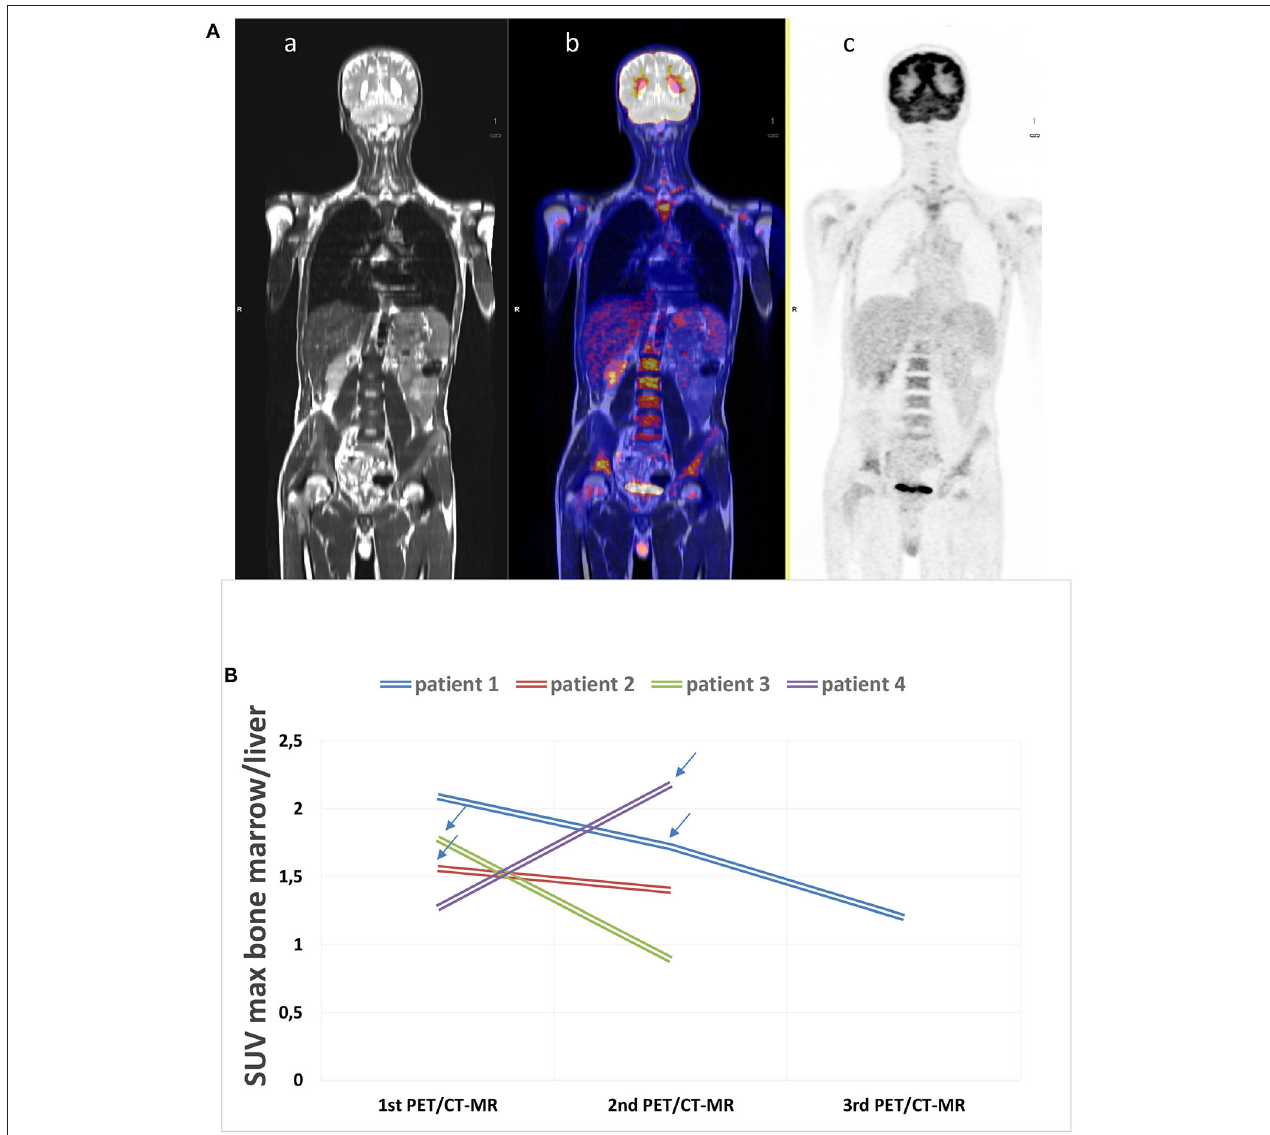
FIGURE 1 | (A) Example of an 18 F-fluorodeoxyglucose ( 18 F-FDG) positron emission tomography with magnetic resonance (PET/CT-MR) scan at disease onset. (a) MR whole-body image, T1 turbo spin echo, coronal (WB_t1_tse_cor), (b) fused image, and c) PET acquisition image with attenuation correction (PET_AC). This scan shows a diffusely increased FDG uptake in the bone marrow (SUVmax 4.12), in the spleen (SUV max 3.13), and in the submandibular lymph nodes (SUVmax 5.61). The patient was diagnosed with adult-onset Still’s disease (AOSD) and started therapy with glucocorticoids after acquiring the images. (B) 18 F-FDG PET/CT-MR was repeated in four patients. The arrows state the moment IL-1 inhibitory therapy was started during the follow-up showing the decrease in bone marrow